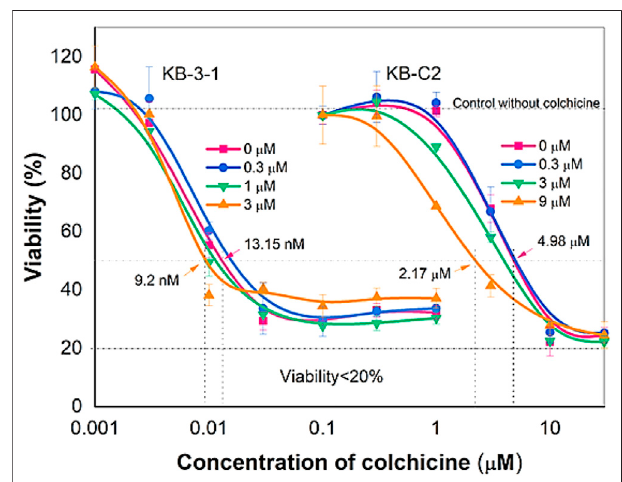
FIGURE 1 | Reversal effect of ribociclib on MDR in KB-C2 cell line. Ribociclib reverses MDR in KB-C2 cells but does not signi fi cantly affect the ef fi cacy of colchicine in the parental KB-3-1 cells. Ribociclib at 9 µM signi fi cantly decreased the IC 50 of colchicine in KB-C2 cancer cells ( p <